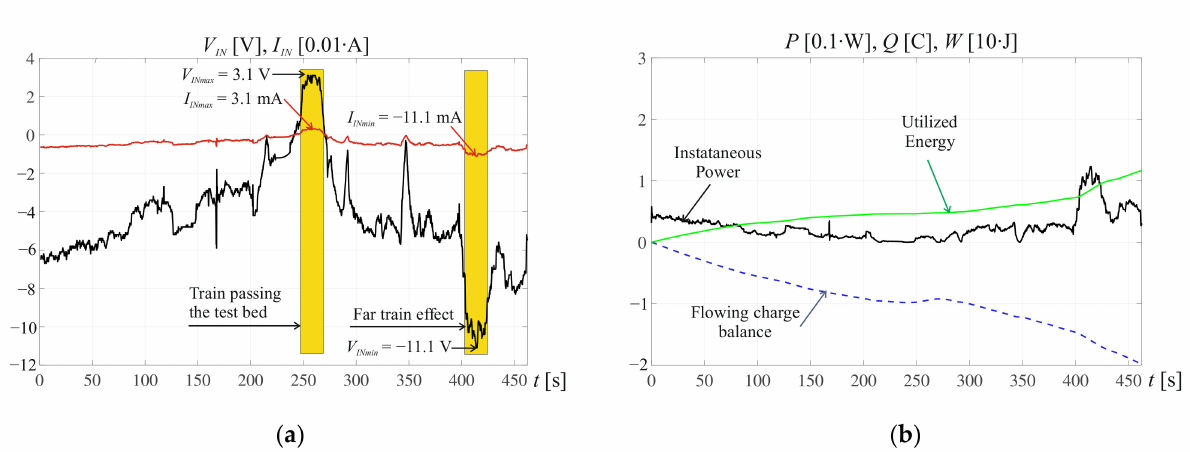
Figure 6. The single local train passing and the influence of the far train (the test bed was moved into the cathodic zone), 462 s of measurements for R IN = 1000 Ω : P max = 123 [mW], P av = 25.1 [mW] and W = 11.6 [J]: ( a ) Voltage (black) and current (red) on the input of the converter; ( b ) The instantaneous power (black), the utilised energy (green) and the flowing charge balance